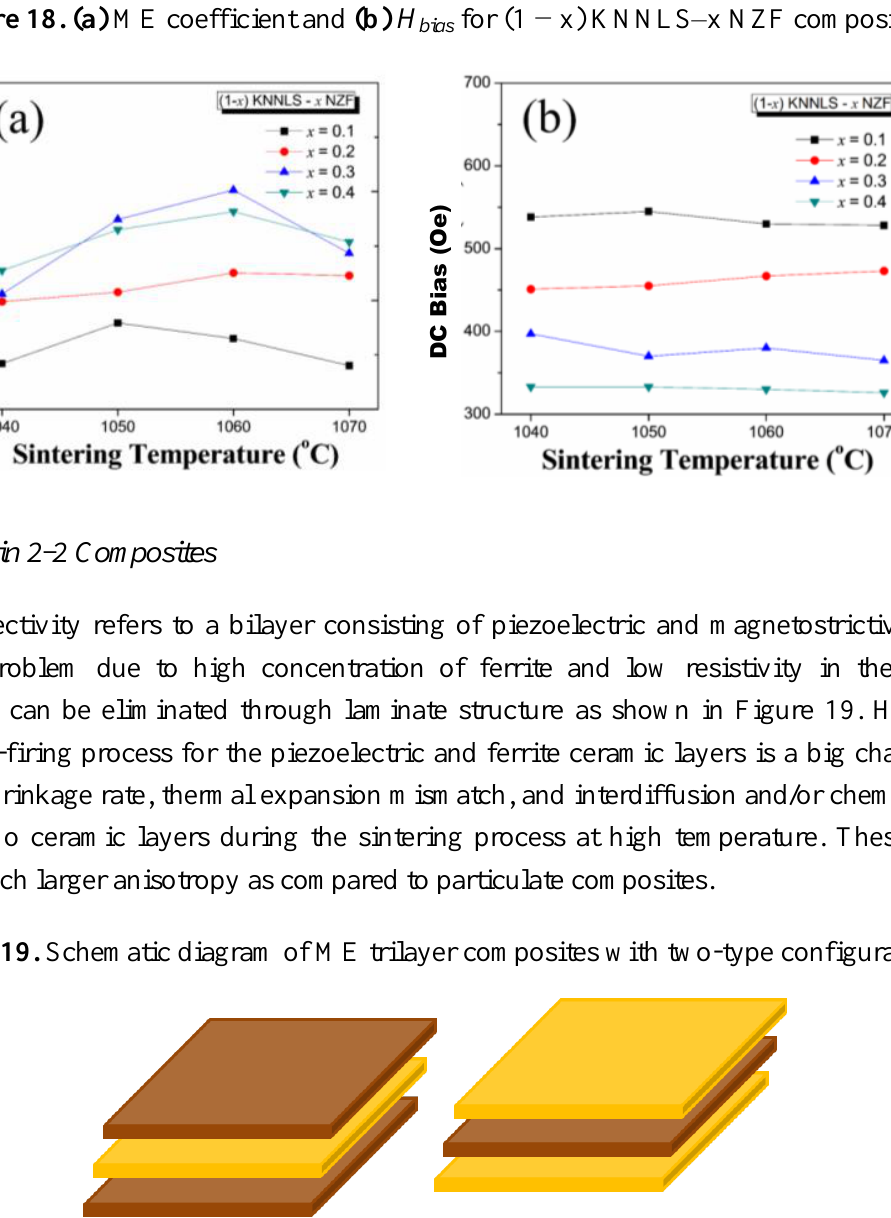
Figure 18. (a) ME coefficient and (b) H